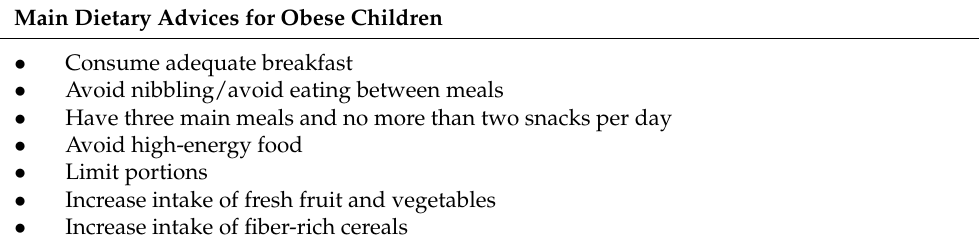
Table 5. Nutritional recommendations for obese children, derived from Valerio G et al. [76]. Main Dietary Advices for Obese